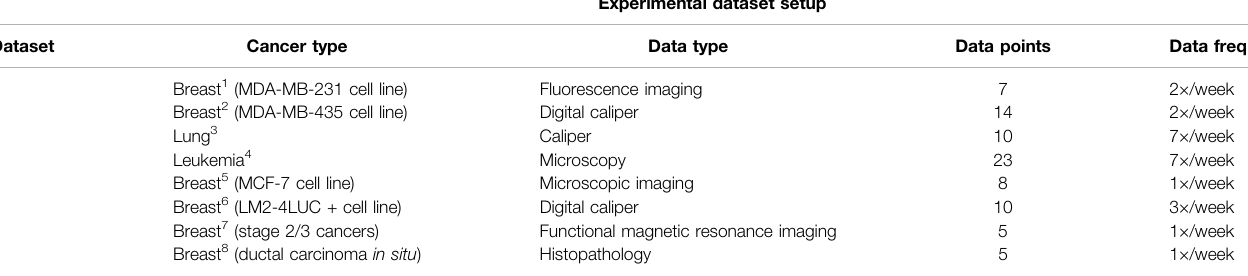
TABLE 1 | Description of the datasets used in the